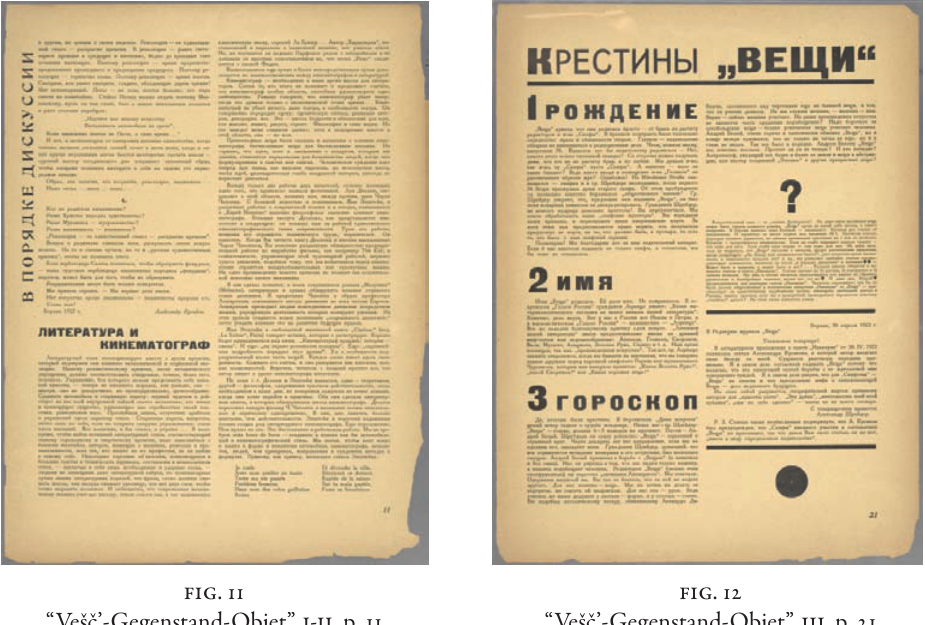
“Vešč’-Gegenstand-Objet”, i-ii, p. 11 “Vešč’-Gegenstand-Objet”, iii, p.